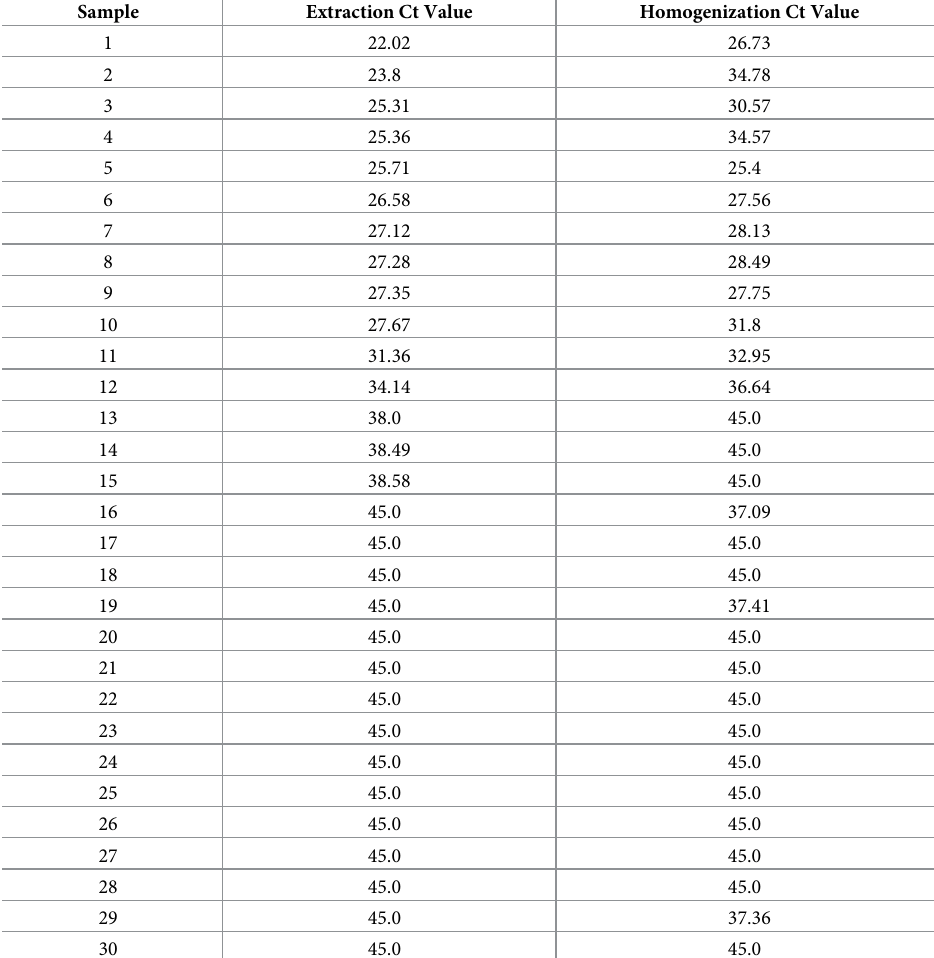
Table 1. RT-qPCR results following the extraction-based and homogenization-based protocols represented as Ct values for each patient sample.